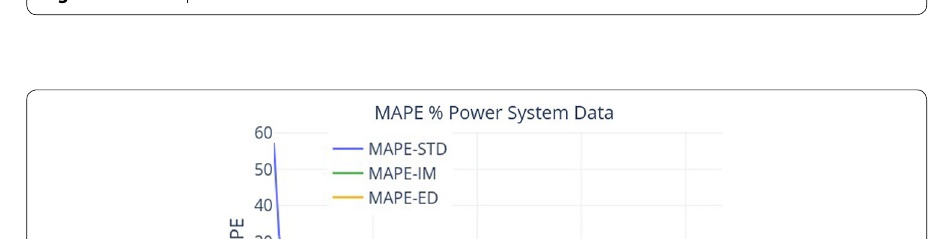
Fig. 7 MAPE comparison of the traffic demanddData